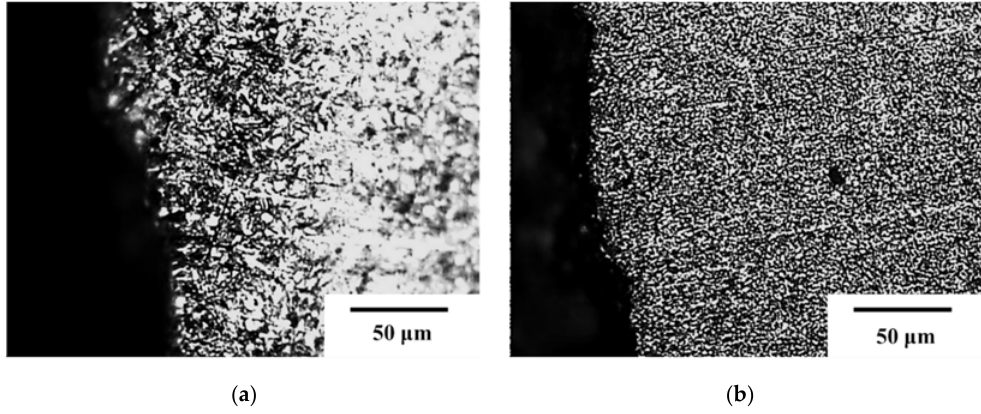
Figure 12. The subsurface of the austempered specimens (1080 °C ‐ 30 min) with a salt ‐ bath temperature of 300 °C and different salt ‐ bath times: ( a ) 30 min, and ( b ) 120 min.